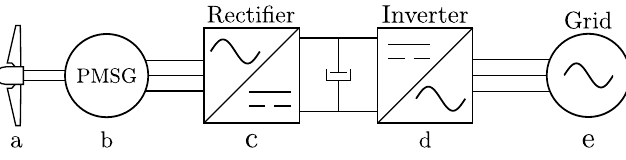
Figure 1. Overview of the considered wind turbine system.